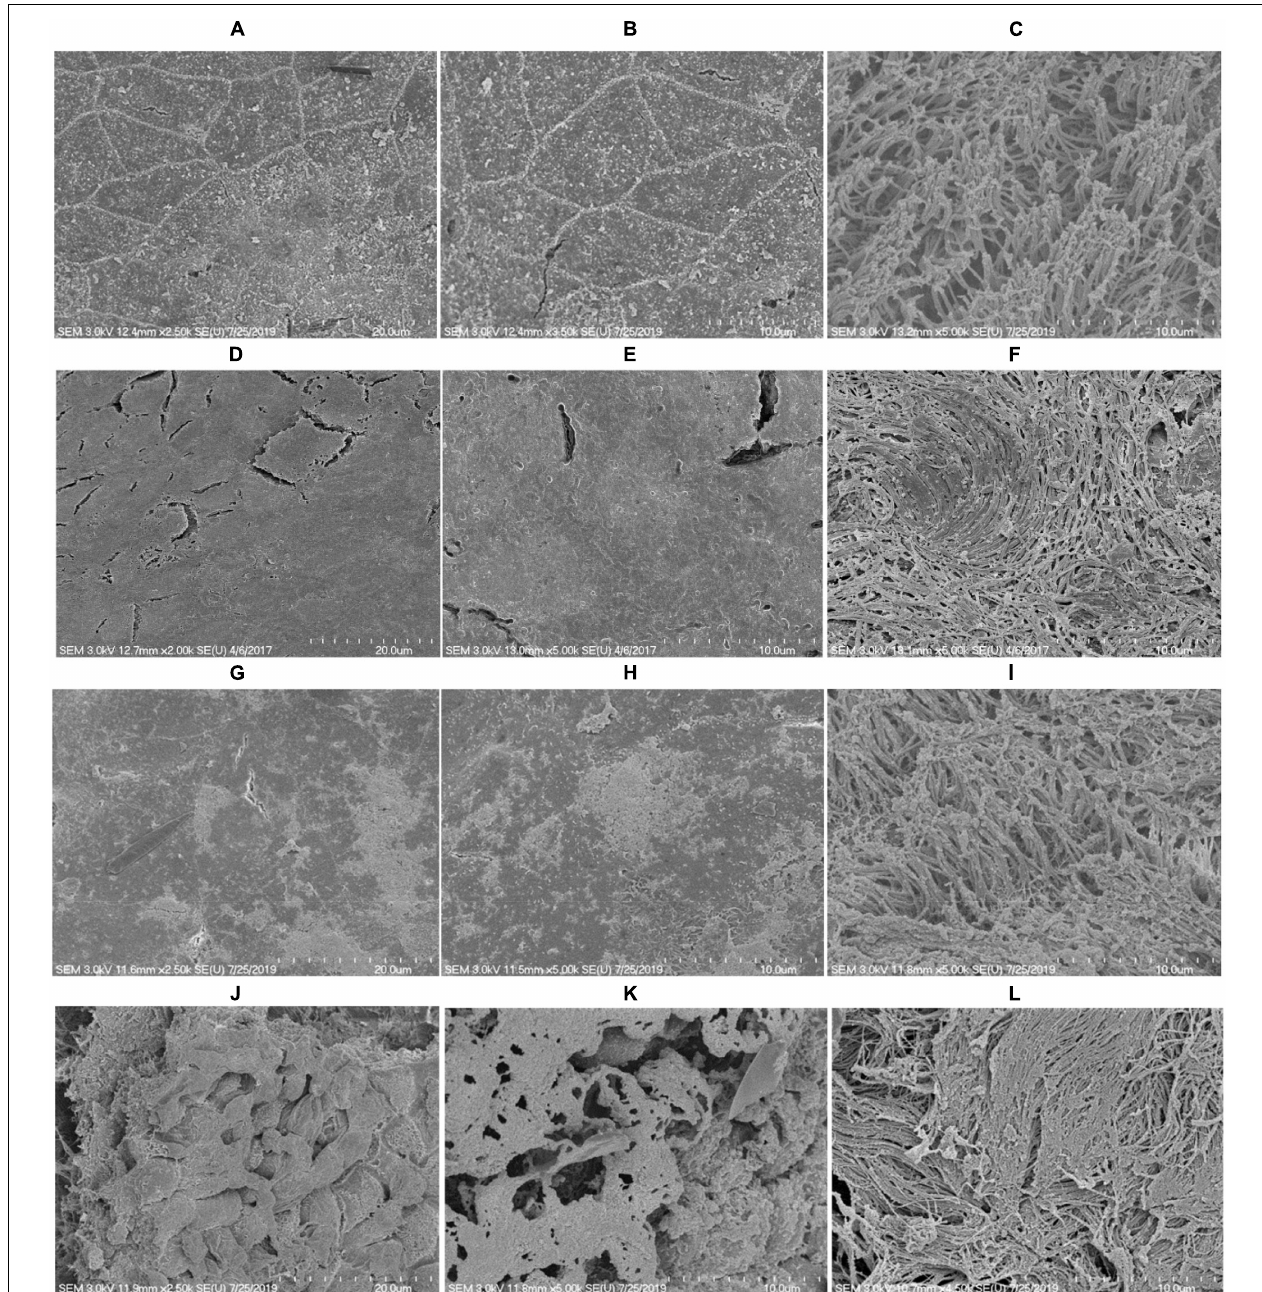
FIGURE 8 | SEM images of rat middle ear colonized with S. pneumoniae D39 in the presence or absence of ASD. (A–C) Are SEM images of rat middle ear of vehicle control. (D–F) Are SEM images of rat middle ear injected with ASD (300 µ g/ml). (G–I) Are SEM images of rat middle ear infected with S. pneumoniae only. (J–L) Are SEM images of rat middle ear injected with ASD + S. pneumoniae